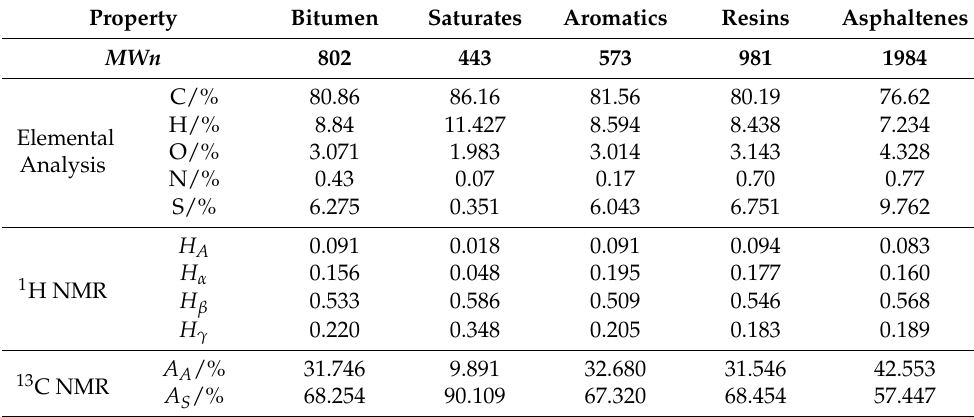
Table 2. The fundamental data of four